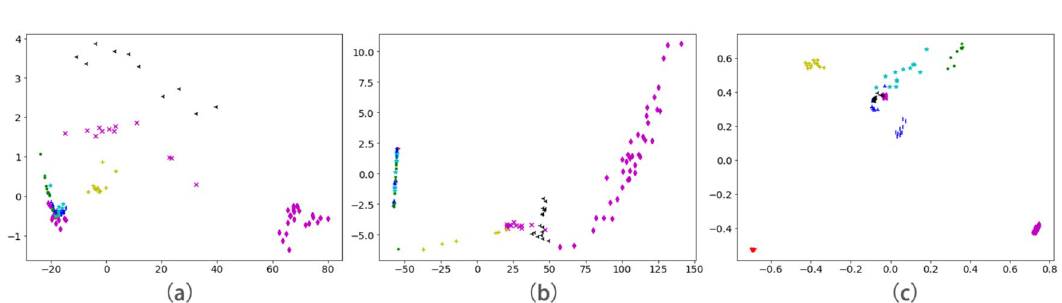
Figure 11. PCA dimension reduction feature visualization: ( a ) SAE; ( b ) SDAE; ( c ) Triplet